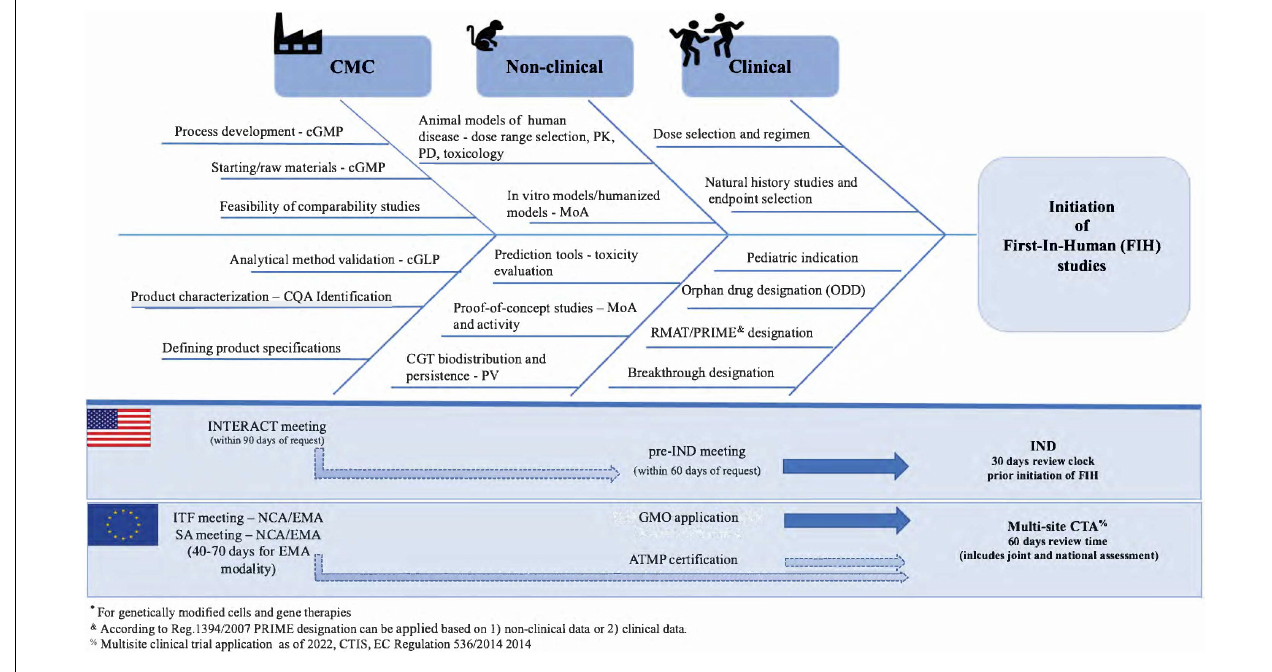
FIGURE 2 | Regulatory risk analysis in early ATMP/CGT